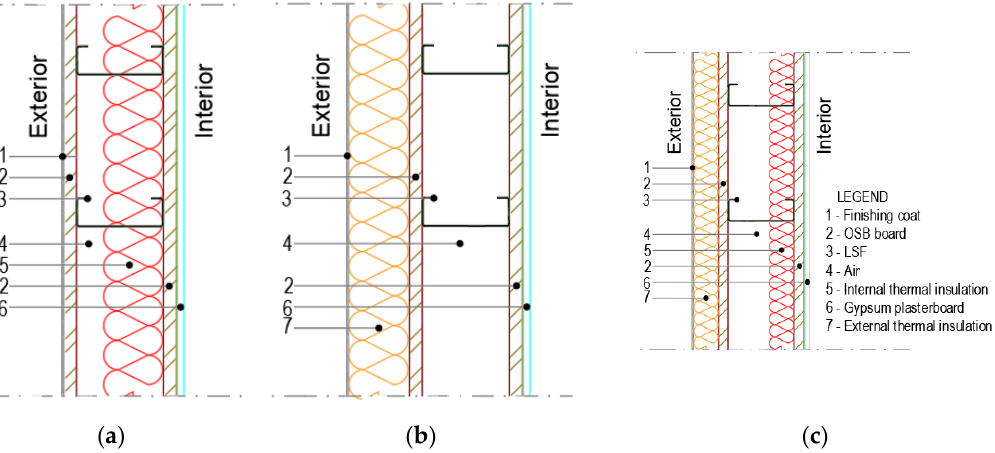
Figure 1. Classification of LSF structures: ( a ) cold frame construction; ( b ) warm frame construction; ( c ) hybrid frame construction.